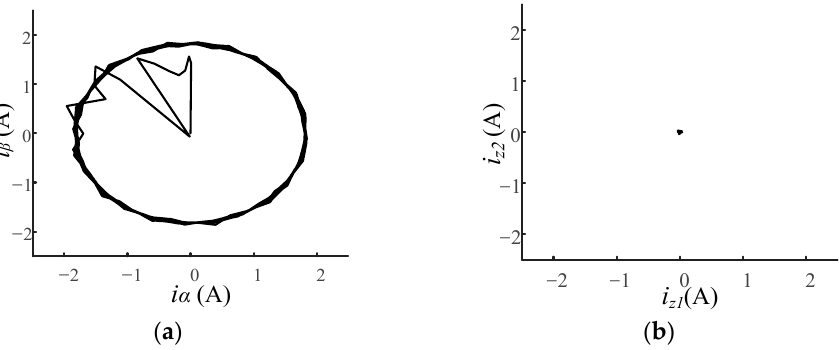
Figure 2. α - β and z 1 -z 2 plane current waveform during normal operation: ( a ) α - β plane current waveform in case of normal operation; ( b ) z 1 -z 2 plane current waveform in case of normal operation.